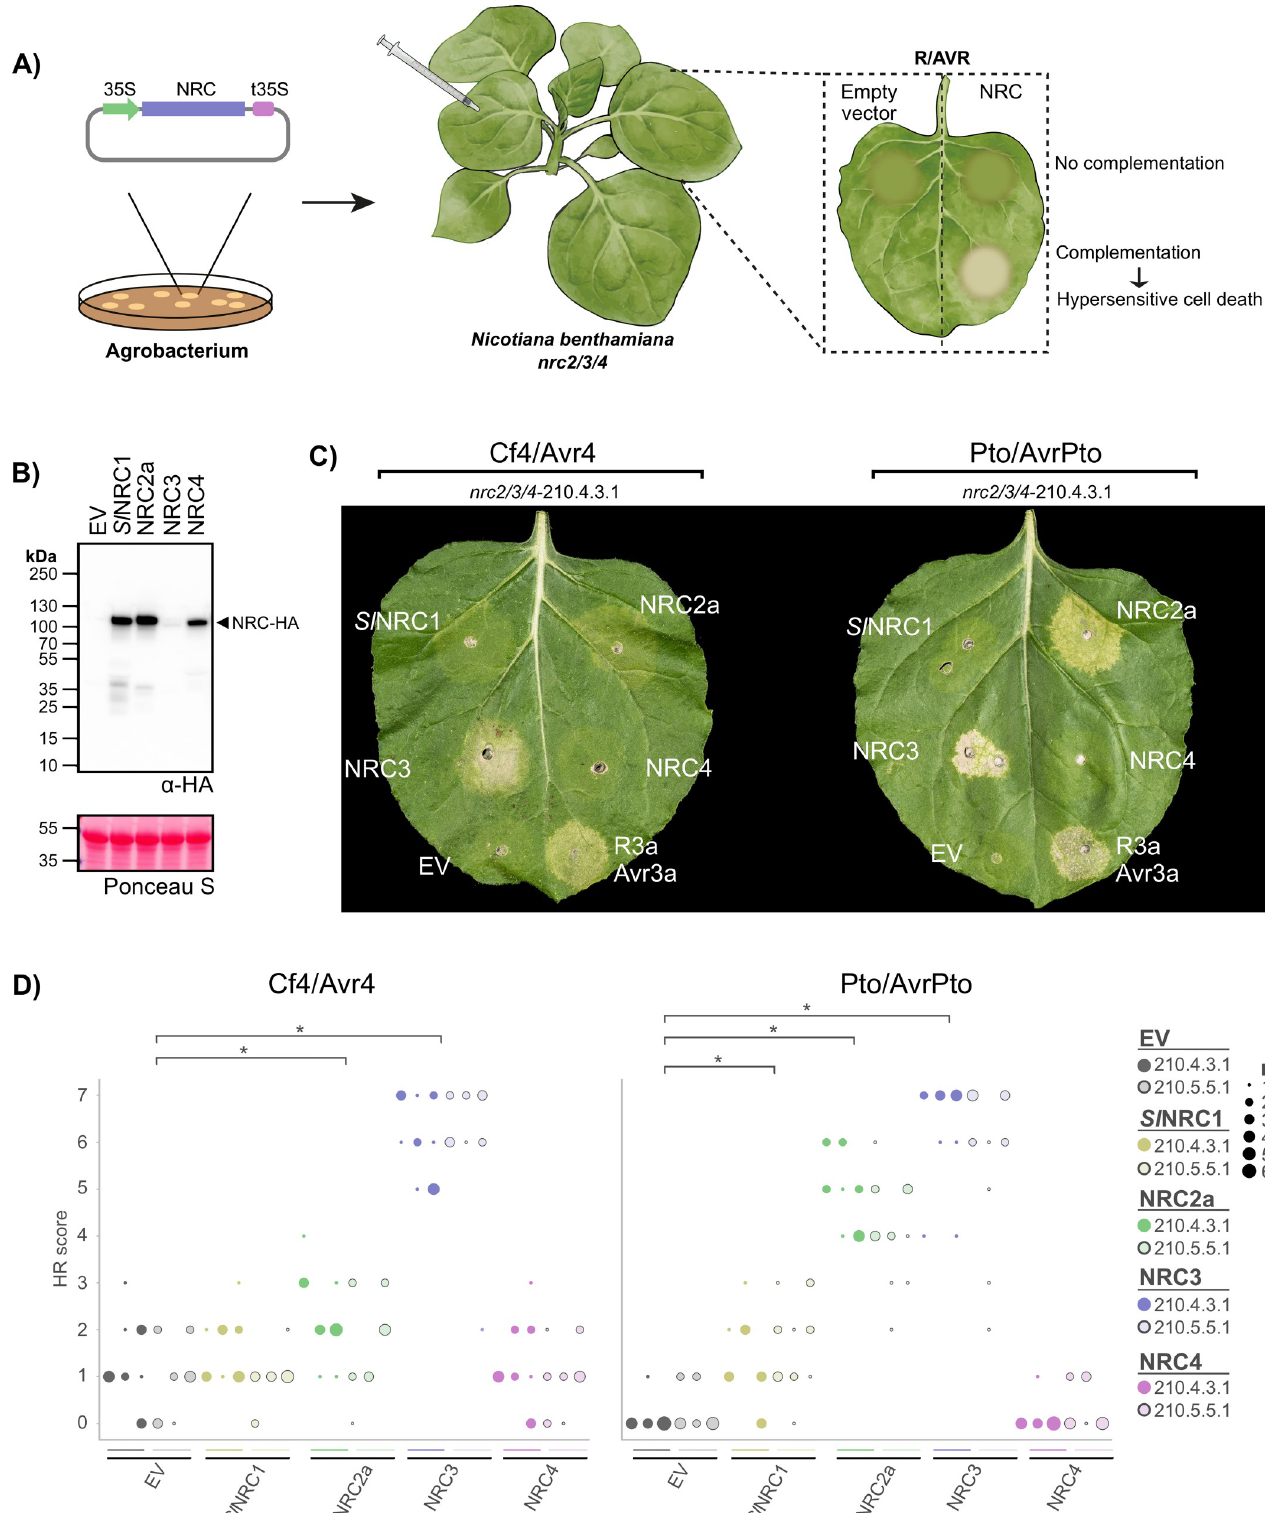
Fig 2. NRC3 complements Cf-4/Avr4-triggered hypersensitive cell death in the nrc2/3/4 knock-out lines. A ) A schematic representation of the cell death complementation assay. NRCs and empty vector (EV) were transformed into A . tumefaciens , and transiently co-expressed in N . benthamiana plants with